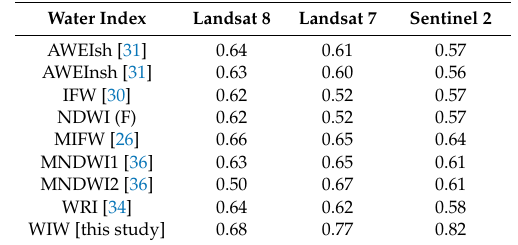
Table 5. Kappa values obtained when applying spectral water indices found in the literature to Sentinel 2 (S2), Landsat 7 (L7) and Landsat 8 (L8) scenes using the ground-truth and optical data available in this study.